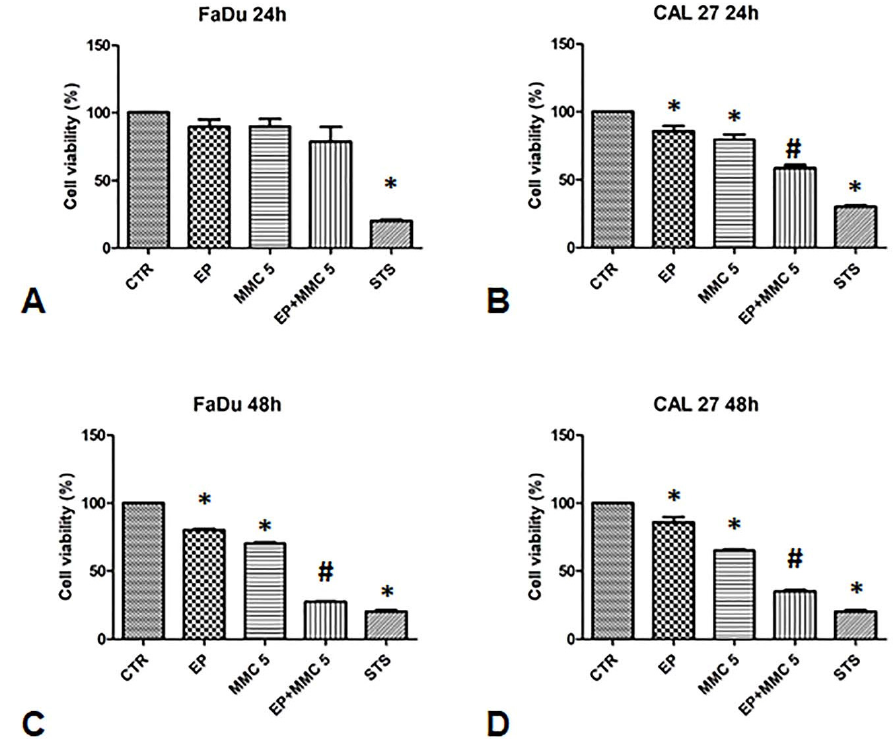
Figure 3. Analysis of the chemosensitizing effect of electroporation (EP) plus MMC on FaDu and CAL 27 cells. MTT assay was performed on FaDu and CAL 27 cells after 24 h ( A , B ) and 48 h ( C , D ) of: EP alone, treatment with MMC 5 µM alone, combination of EP plus MMC 5 µM, or treatment with staurosporine (STS) 1 µM. The results obtained from three independent experiments, each in sixfold, were expressed as mean ± standard deviation: *: p < 0.05 vs. control; #, p < 0.05 vs. MMC. When FaDu cells were treated with EP alone for 24 and 48 h, cell viability was 80%; when they were treated with MMC (5 µ M) it was 80% after 24 h and slightly lower after 48 h (75%). The combined treatment of EP plus MMC (5 µ M) showed relative viability of 70% after 24 h, and 35% after 48 h (Figure